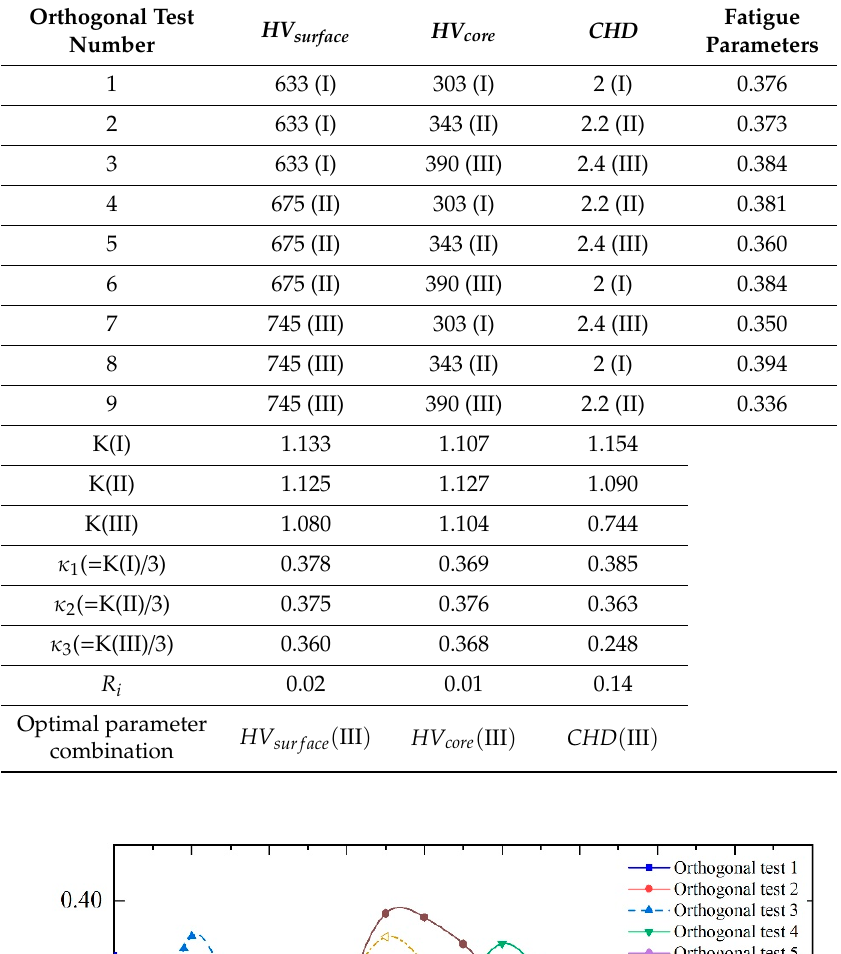
Table 4. Three-parameter orthogonal test table.